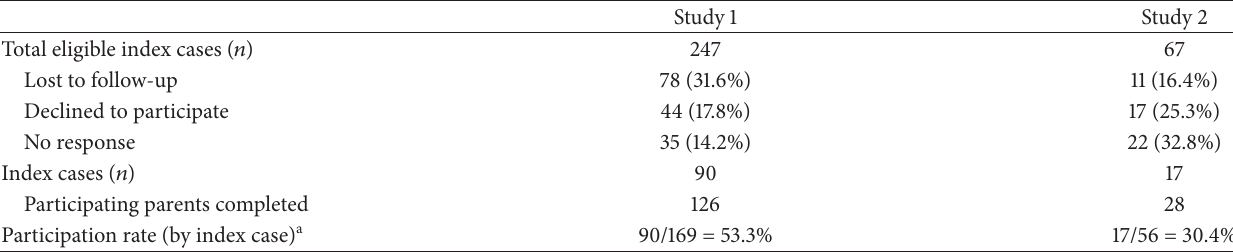
Table 1: Participation